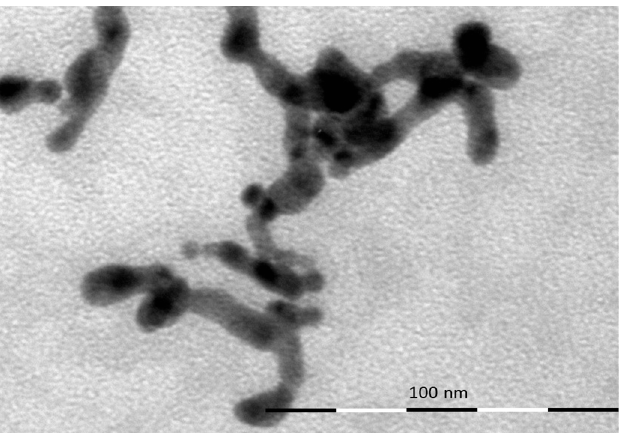
Figure 8. Bright-field TEM image of the Au nanoparticles (scale bar = 100 nm).